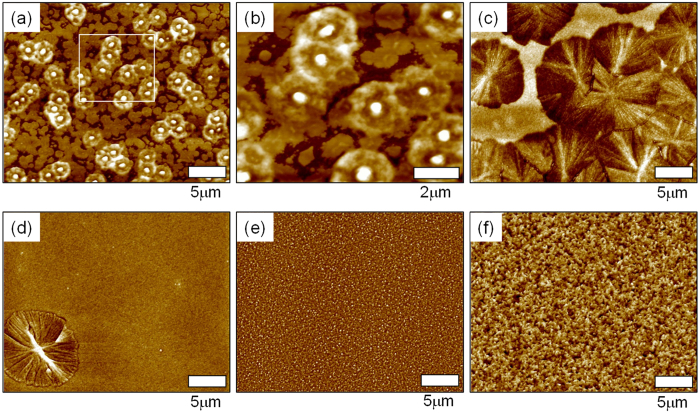
AFM topographies of Thermally annealed In(NO3)3 films onto ZrO2 surfaces.(a,b) 130 °C, (c) 170 °C, (d) 250 °C, (e) 400 °C, and (f) 500 °C for 1 h.